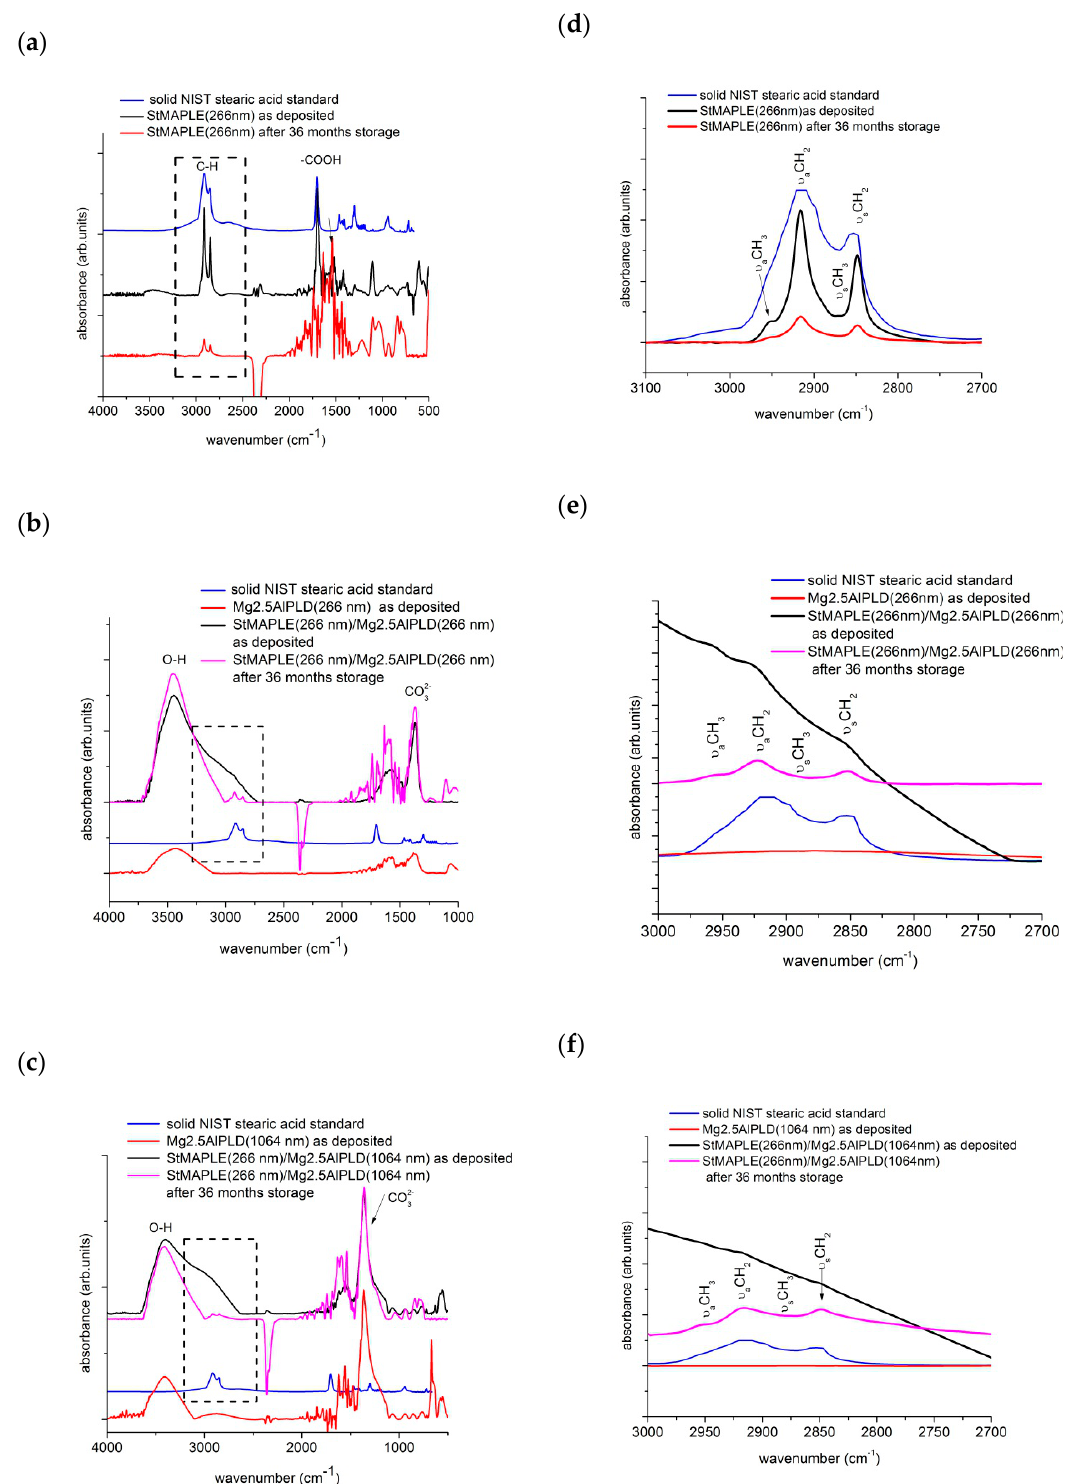
Figure 6. FT-IR spectra of as deposited films, of the stearic acid deposited via MAPLE ( a ) and of the composite films deposited via a combined MAPLE-PLD deposition ( b ) and ( c ). The FT-IR spectrum of the solid NIST (National Institute of Standards and Technology-US) is included. In the right column, the detailed spectra from 3000–2700 cm − 1 wavenumbers are exposed, emphasizing the ν a CH 2 and the ν a CH 3 bands ( d ), ( e ) and ( f ), respectively.